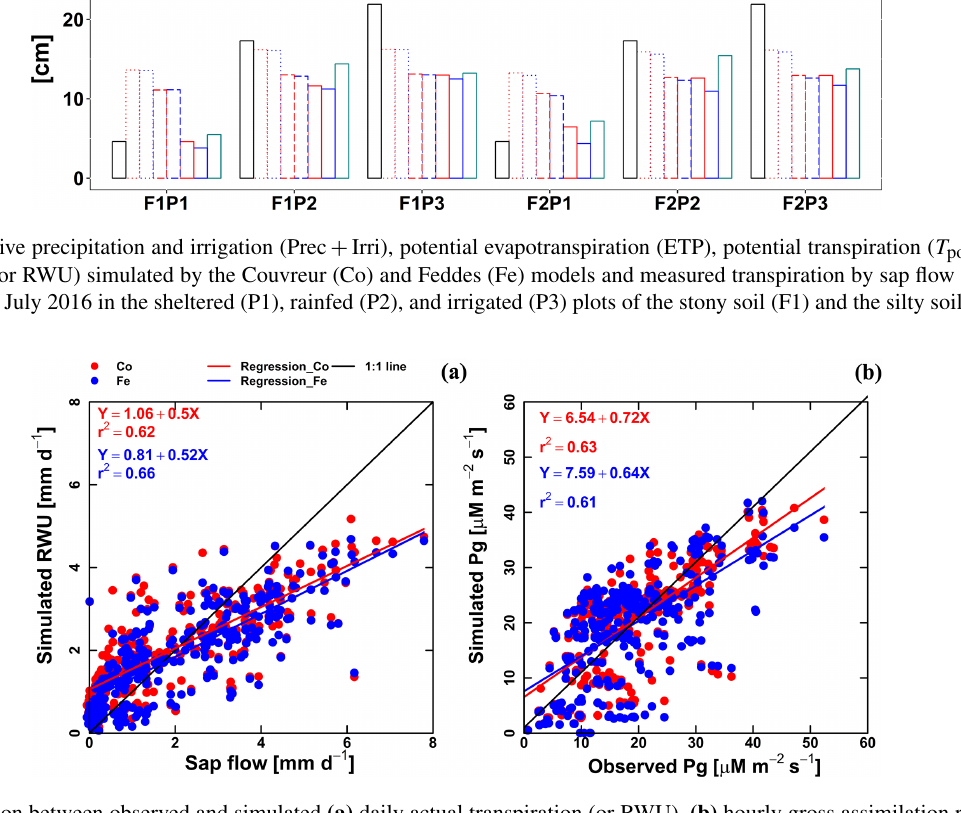
Figure 7. Correlation between observed and simulated (a) daily actual transpiration (or RWU), (b) hourly gross assimilation rate ( P g ) from the Couvreur (Co; red dot) and Feddes (Fe; blue dot) models of both fields (F1 and F2). Sap flow data were from 26 May until 20 July 2017 ( n = 312). Gross assimilation rate from 8 measurement days ( n = 302). The RMSE in (a) is given in mmd − 1 , while the RMSE in (b) is given in µMm − 2 s − 1